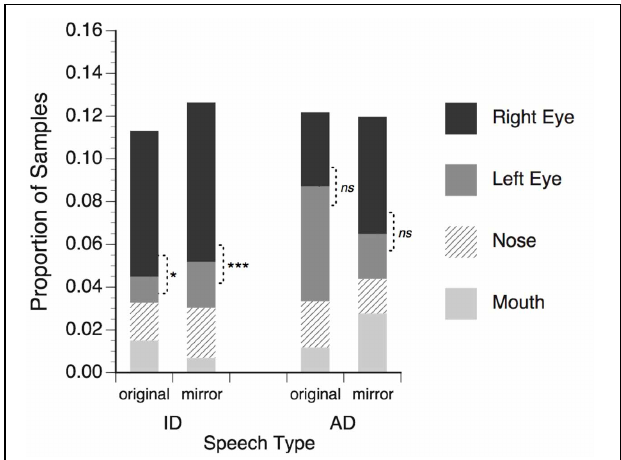
FIGURE 3 | Proportion of total eye tracker samples in which adults’ gaze fell within regions of interest around talker’s facial features. Right eye refers to the talker’s right eye, which appeared on the left side of the screen. Significance tests for differences between right and left eye; ∗ p < 0 . 05; ∗∗∗ p < 0 . 001, ns =